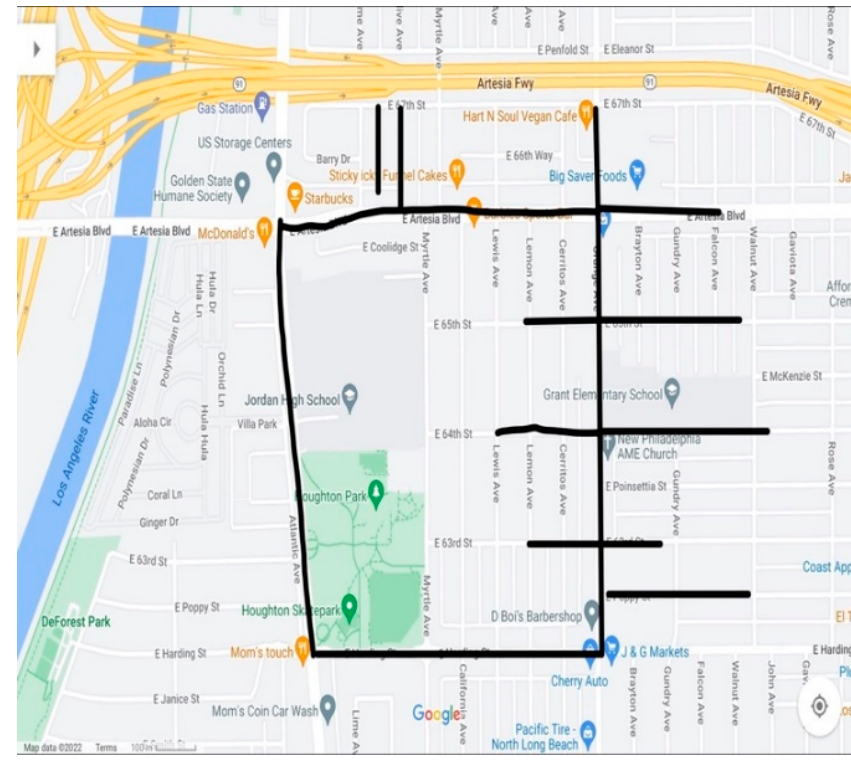
Figure 3. Path walked in North Long Beach.